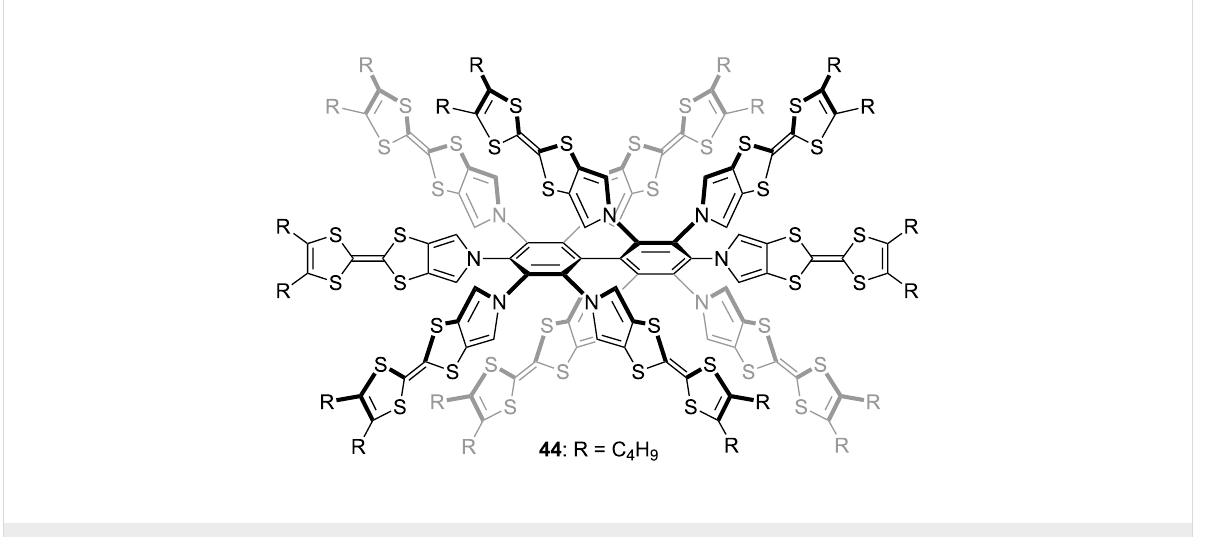
Figure 13: Star-shaped TTF 10-mer 44 .